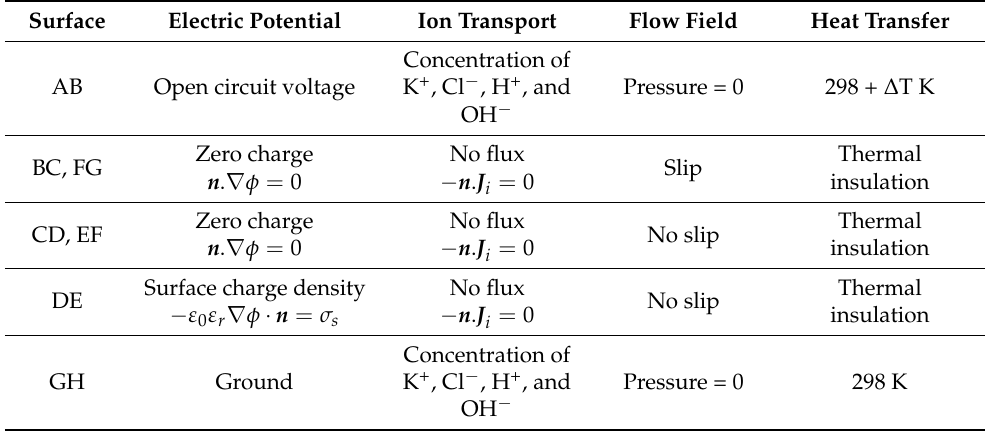
Figure 2. Illustration of charge-regulated surface controls thermo-osmosis. Table 1. Boundary conditions for axisymmetric model.